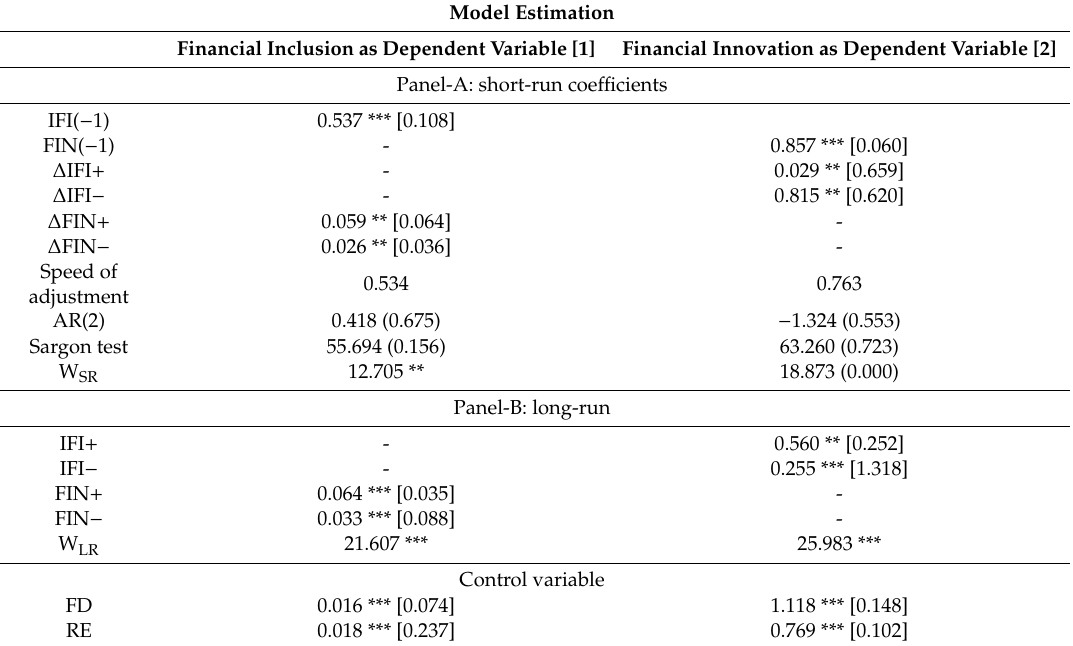
Table 8. Short- and long-run generalized method of moments (GMM) estimates and symmetry tests. Model